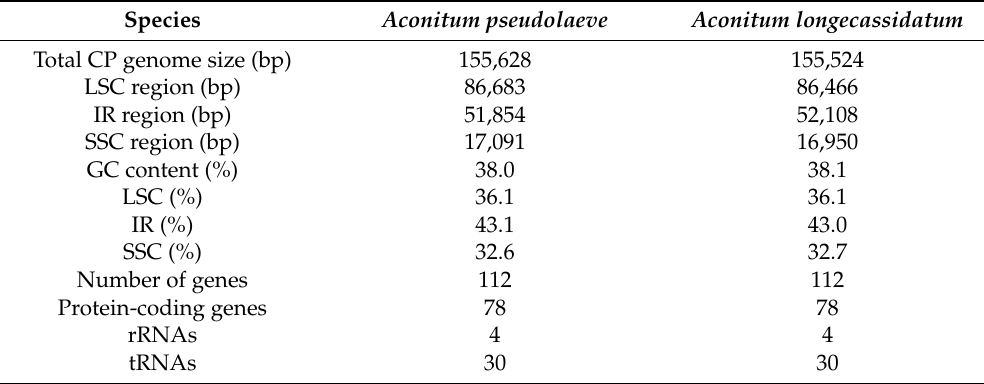
Table 1. Size comparison of two Aconitum species’ CP genomic regions.